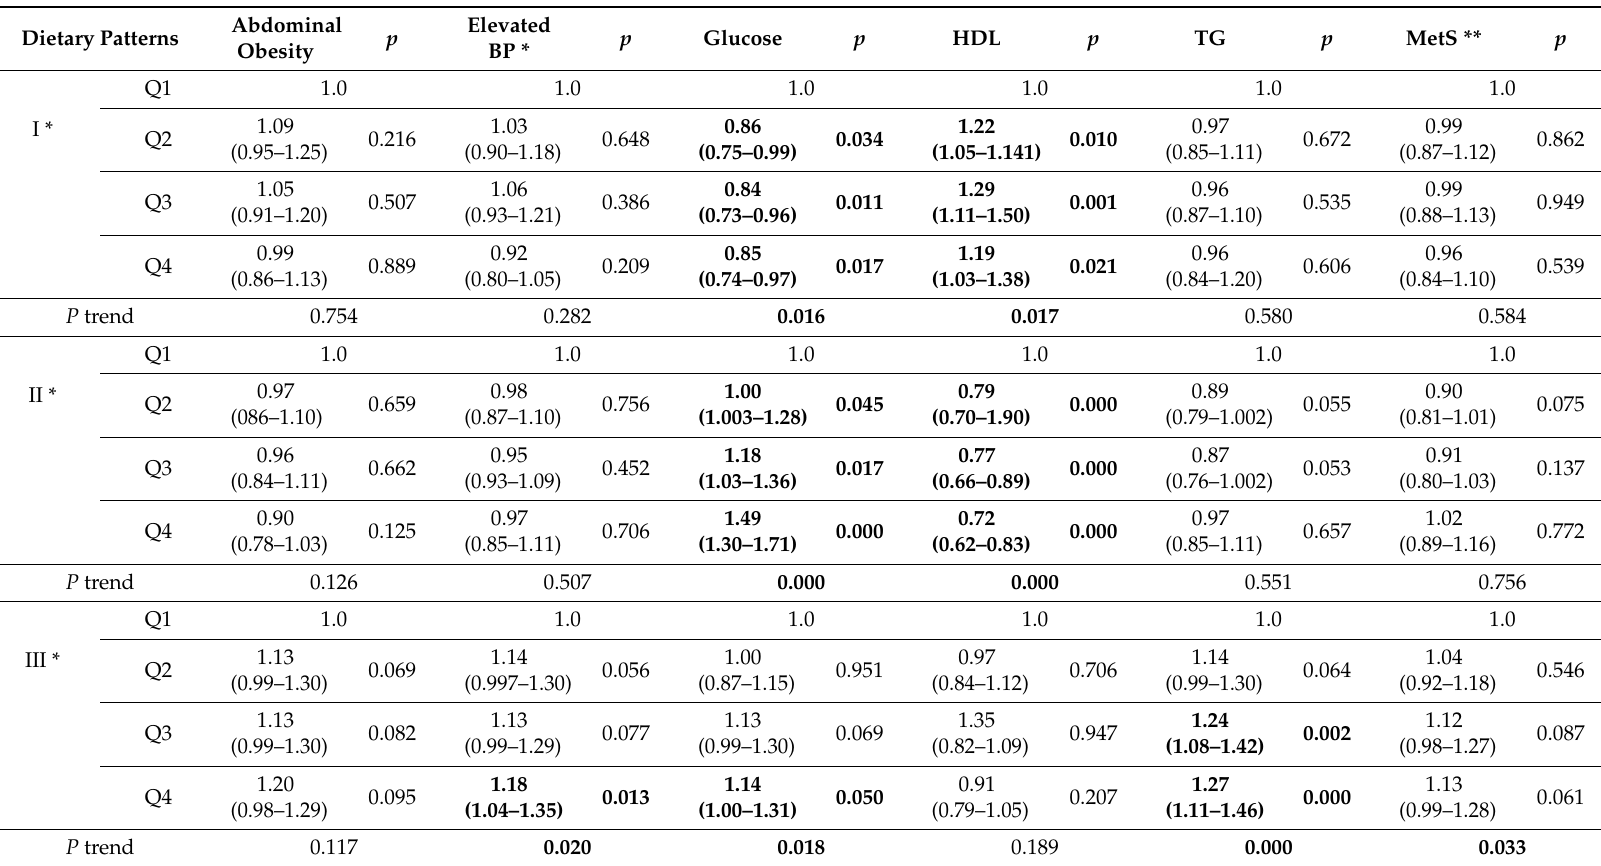
Table 3. Risk of MetS and its components occurrence in quartile categories of the dietary patterns (Model I—unadjusted) odds ratios (OR) and their 95% confidence intervals (95%